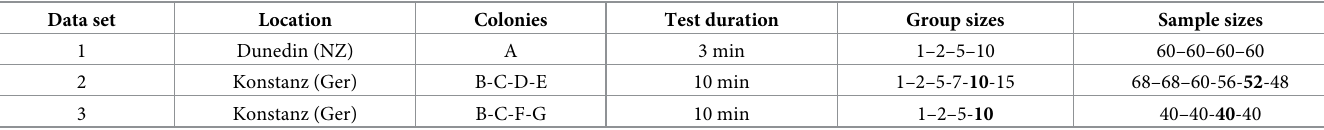
Table 1. Summary of the experimental data collected. Data